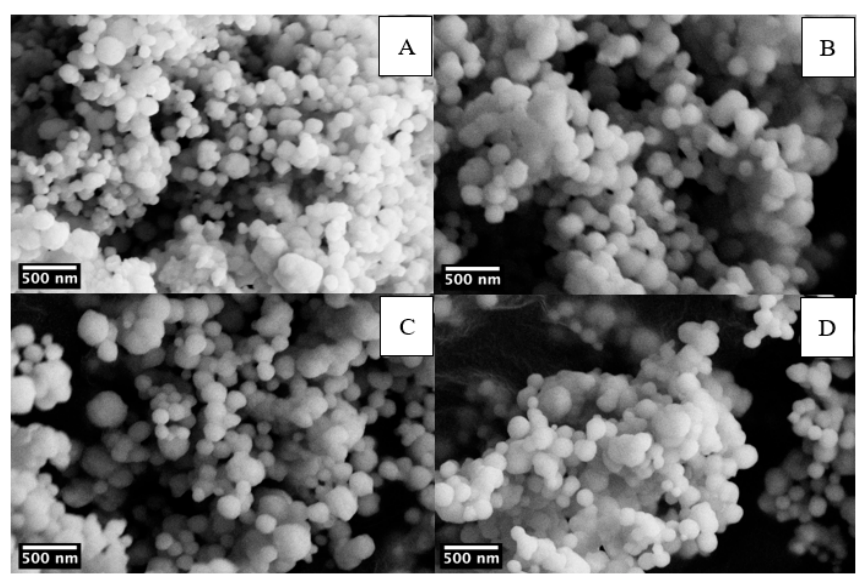
Figure 10. SEM micrographs of BT doped particles: BT_H_Na_900 ( A ), BT_H_Ca_900 ( B ),